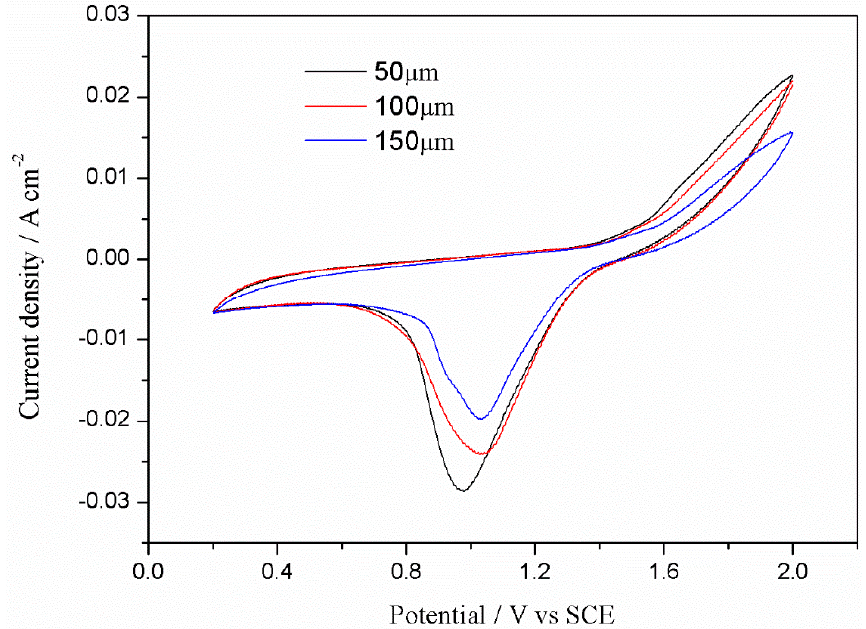
Figure 5. Cyclic voltammetry curve of porous Ti/SnO 2 –Sb 2 O 3 /PbO 2 electrodes in 0.5 mol L − 1 H 2 SO 4 solution at a scan rate of 5 mV·s − 1.